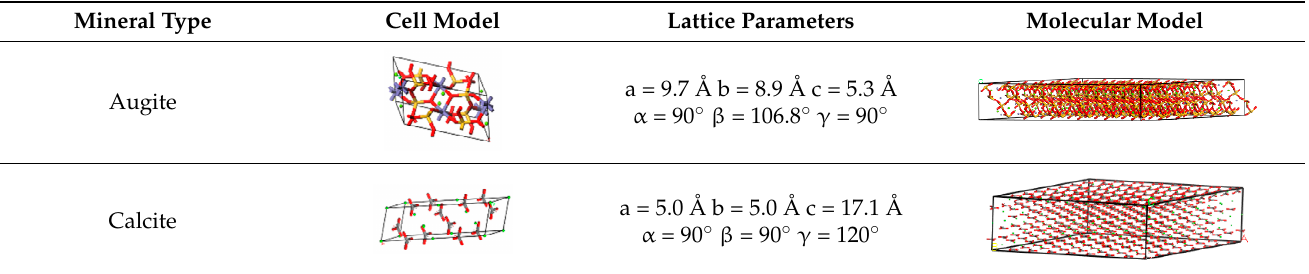
Table 9. The representative aggregate molecular models and information.